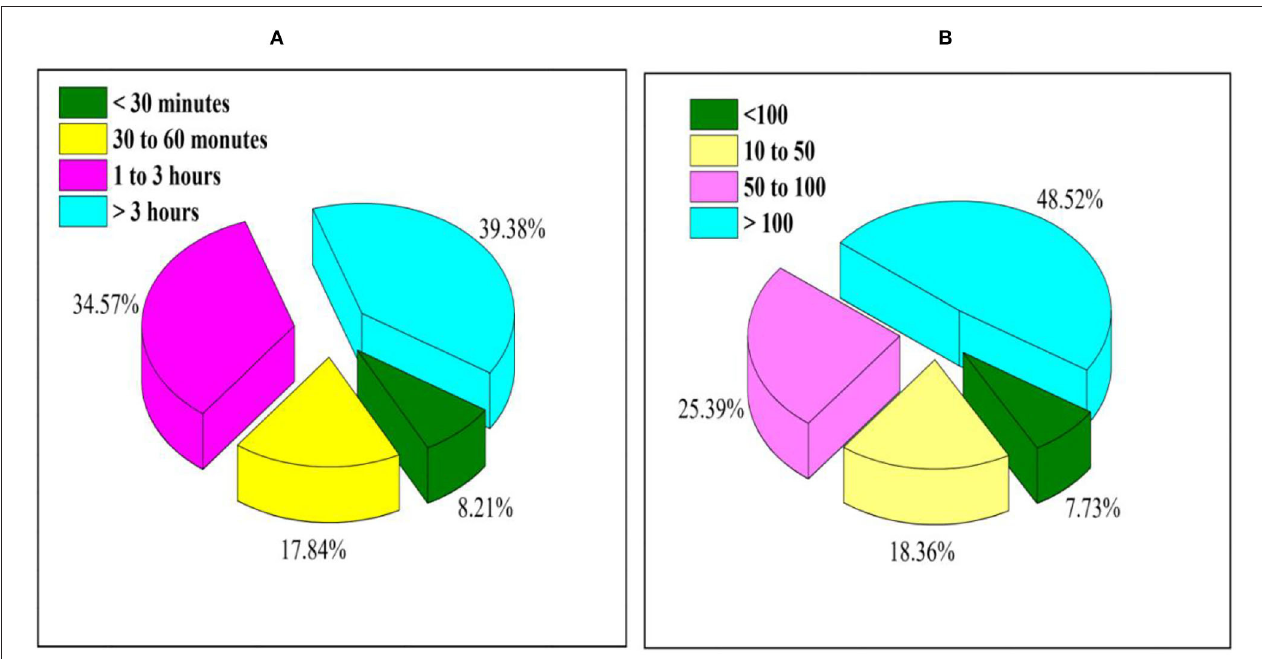
FIGURE 1 | Usage analysis of m-banking application (A) Users using m-banking during the day and (B) users’ friends and references using mobile